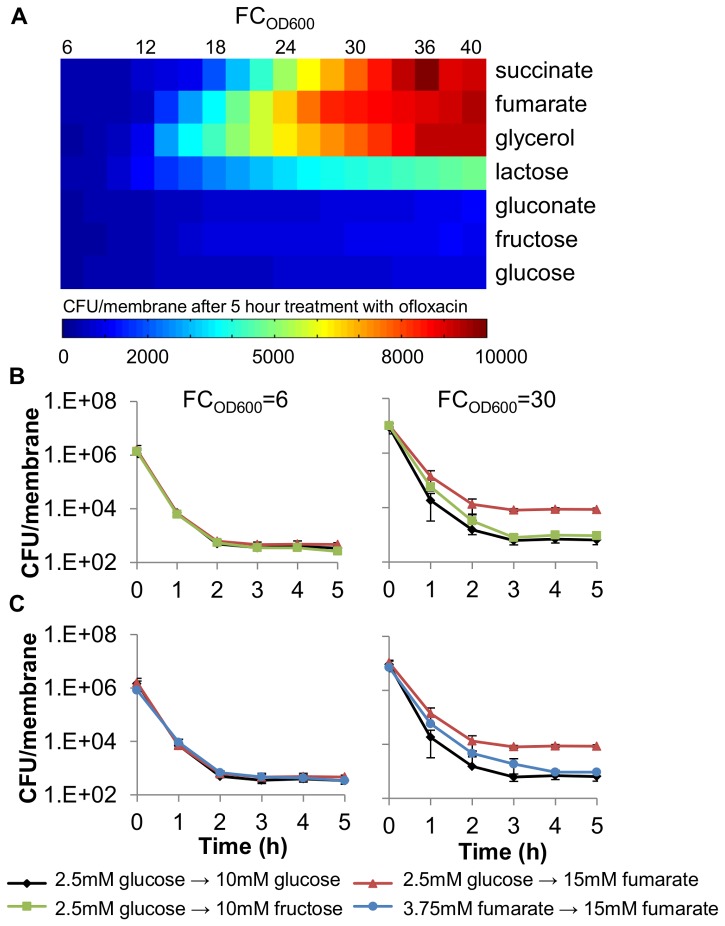
Diauxic shifts stimulate persister formation in biofilms.(A) E. coli were grown on glucose as the primary carbon source and a panel of secondary carbon sources. At hourly time points, biofilms were challenged with 200 μl of 10 μg/mL ofloxacin for 5 h, aseptically removed from the agar, vortexed in 2 mL PBS for 1 minute, washed, and plated to measure CFUs. To construct the color plot as a function of FCOD600, as needed values plotted were interpolated from two adjacent measurements. Raw values are presented in Table S2. (B) Diauxic growth (glucose-fumarate) results in significant persister formation (p<0.05), whereas non-diauxic growth does not (p>0.05) (glucose and glucose-fructose) when comparing persister levels 5 h post-antibiotic treatment. Time on the x-axis represents time after antibiotic treatment. (C) Growth on fumarate is not responsible for persister formation in glucose-fumarate samples, as evidence by sole fumarate control, which contained fumarate as the only carbon source both in the inoculum and agar. Data are averages of ≥3 independent experiments, error bars indicate standard deviation, and significance was assessed using the null hypothesis that the mean CFU levels in two sample sets were equal.